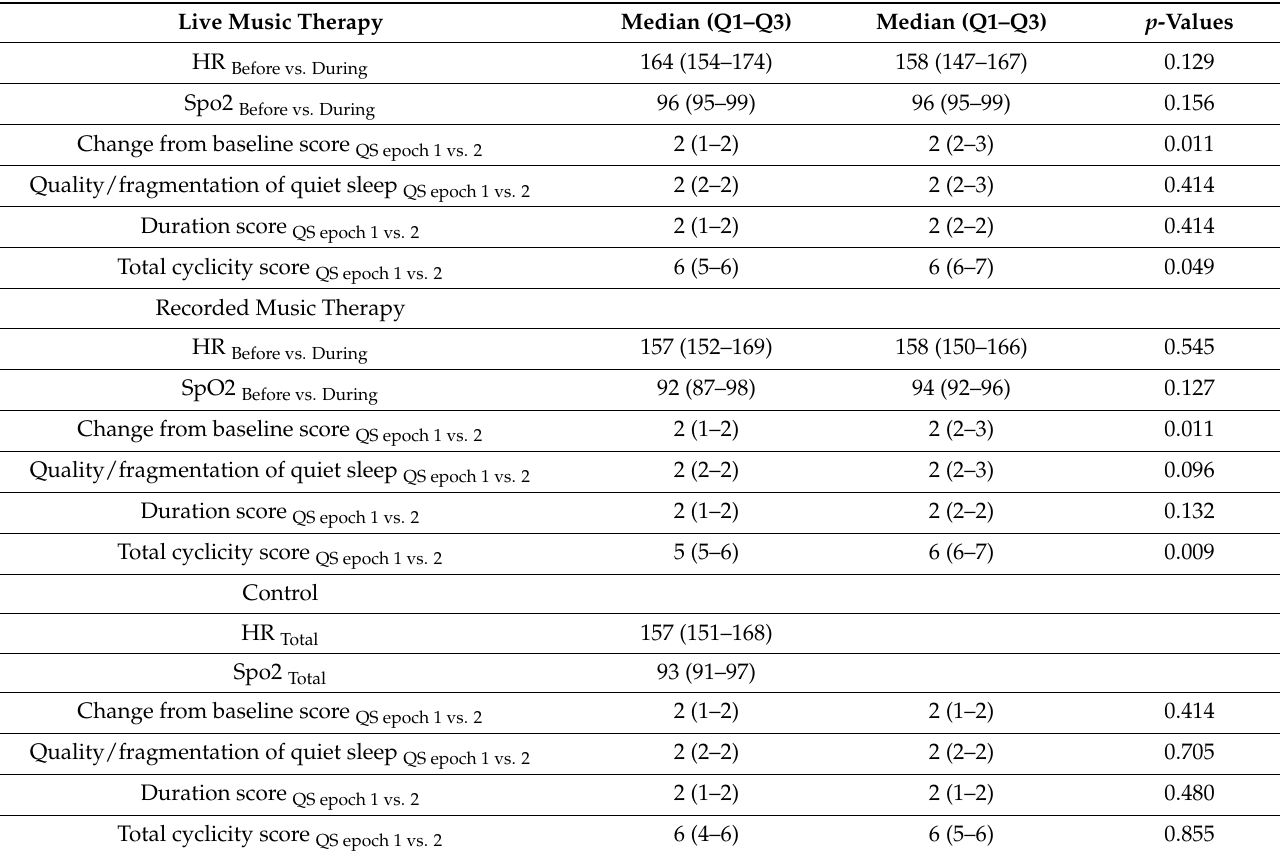
Table 3. Change in vital signs and aEEG parameters within the groups before and after music